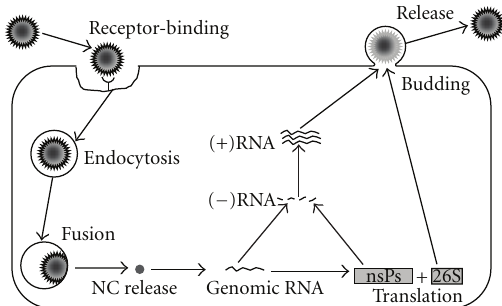
Figure 2: Alphavirus life-cycle. Alphavirus entry into cells is initiated by receptor-binding, followed by clathrin-mediated endo- cytosis. Fusion to endosomal membranes transports nucleocapsid (NC) into the cytoplasm, where RNA is released after disassembly. Genomic RNA is used for both translation of proteins from genomic and subgenomic (26S) RNA, and transcription of nascent (+)RNA via a ( − )RNA template. The structural proteins translated from 26S RNA encapsidate nascent genomic RNA before budding from cells, and eventual